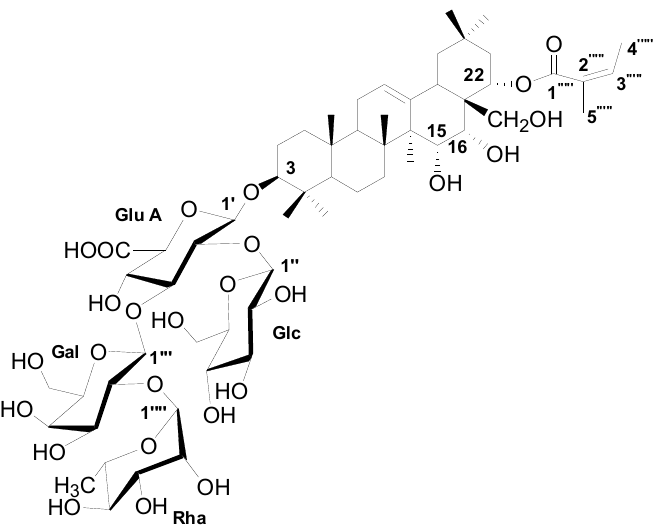
Figure 7. The chemical structure of compound 1 .